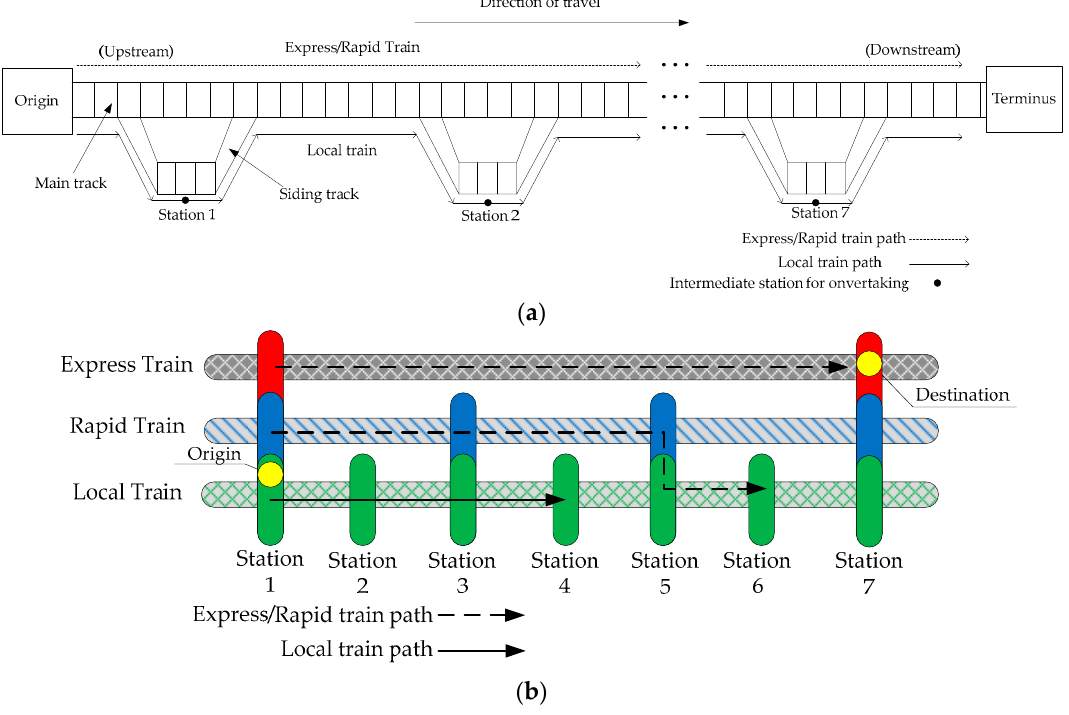
Figure 1. Stop-skipping represented by two fundamental graphs. ( a ) Topology of rail transit system investigated in this study; ( b ) Fundamental graph for five typical forms